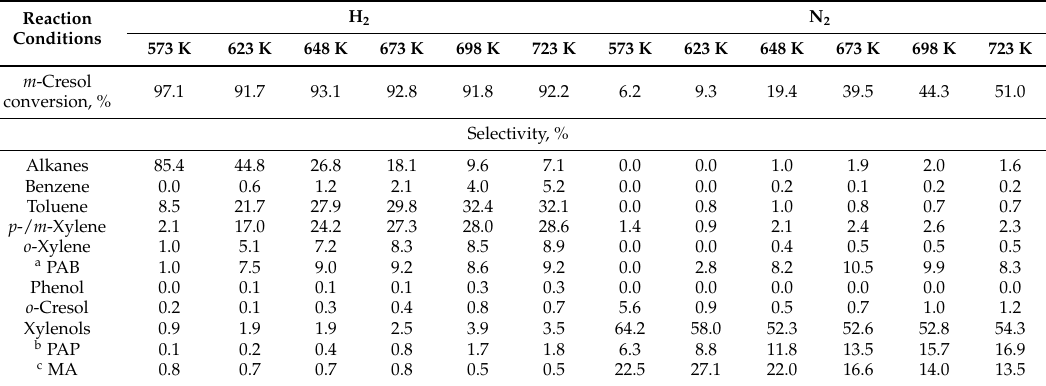
Table 1. Effect of carrier gas on the product distribution from converting m -cresol with methanol. H 2 N Reaction Conditions